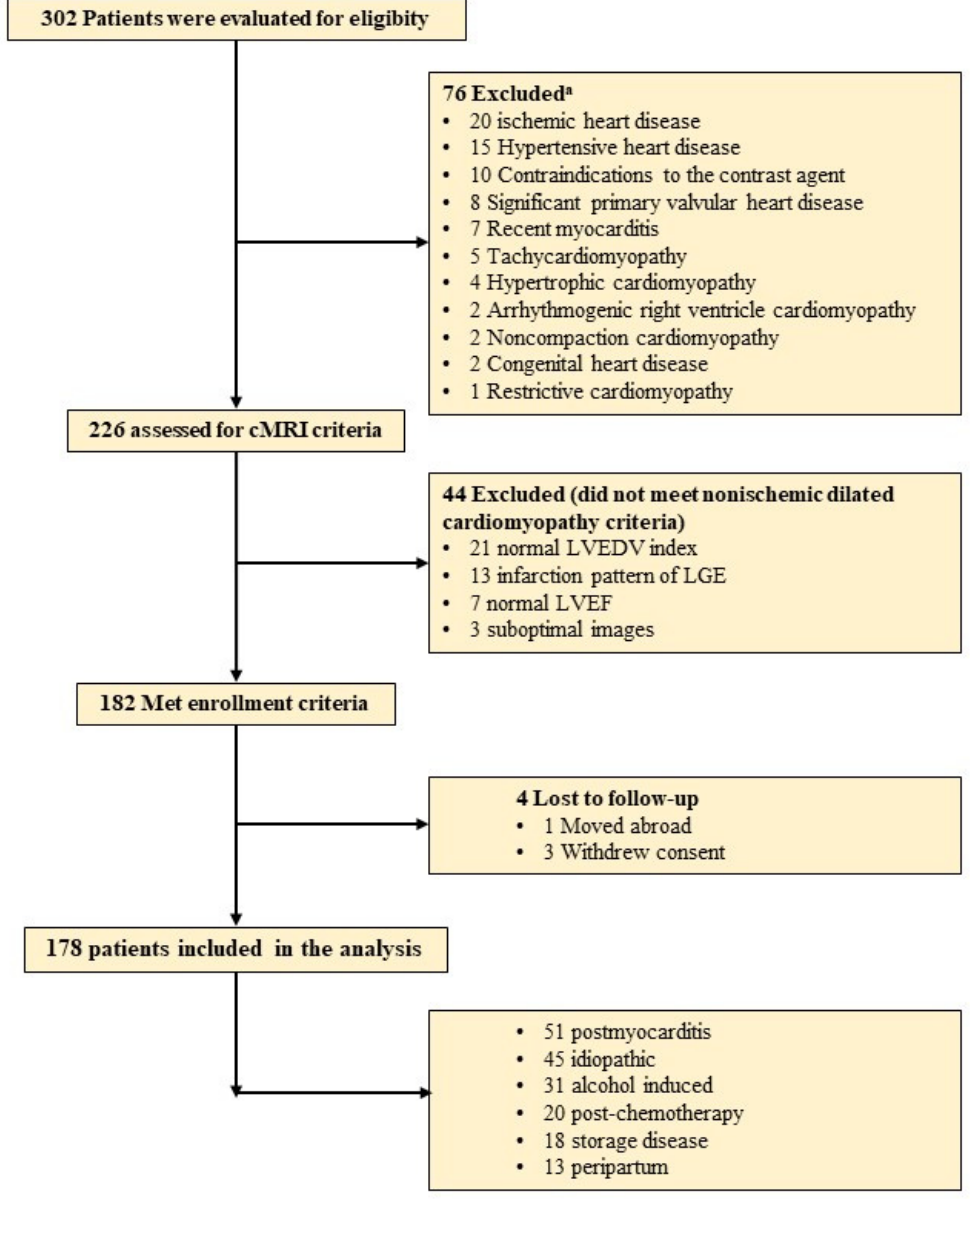
Figure 1. Flow chart detailing the identification of the study cohort. Abbreviations: cMRI, cardiac magnetic resonance imaging; LGE, late gadolinium enhancement; LVEDV, left ventricular end diastolic volume; LVEF, left ventricular ejection fraction.